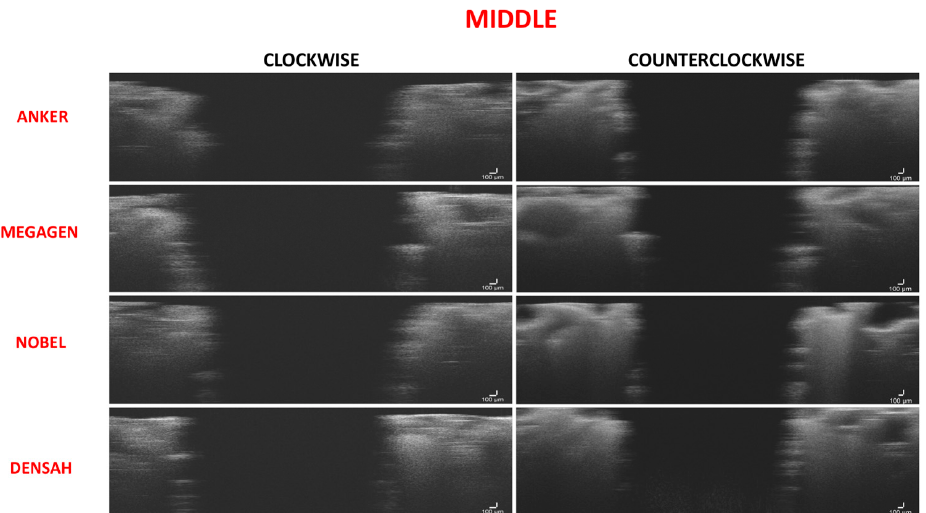
Figure 8. Figure composition showing representative samples of 2D sections at the middle region for clockwise and counterclockwise drilling for all of the drill designs. Microfractures were observed in all the implant bed walls. Some of the empty spaces of the cancellous area were exposed to the implant bed intaglio. Wall density appeared the same for both drilling directions.